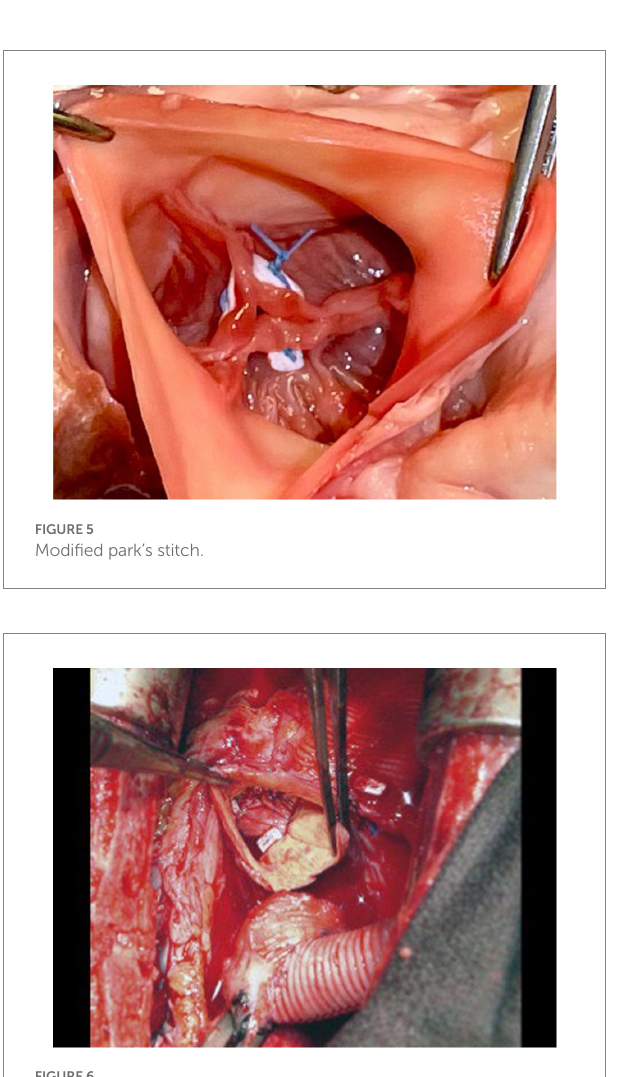
FIGURE 6 A circular patch of bovine pericardium was sutured circumferentially to the aortic annulus above the native aortic valve leaflets. Reproduced with permission from